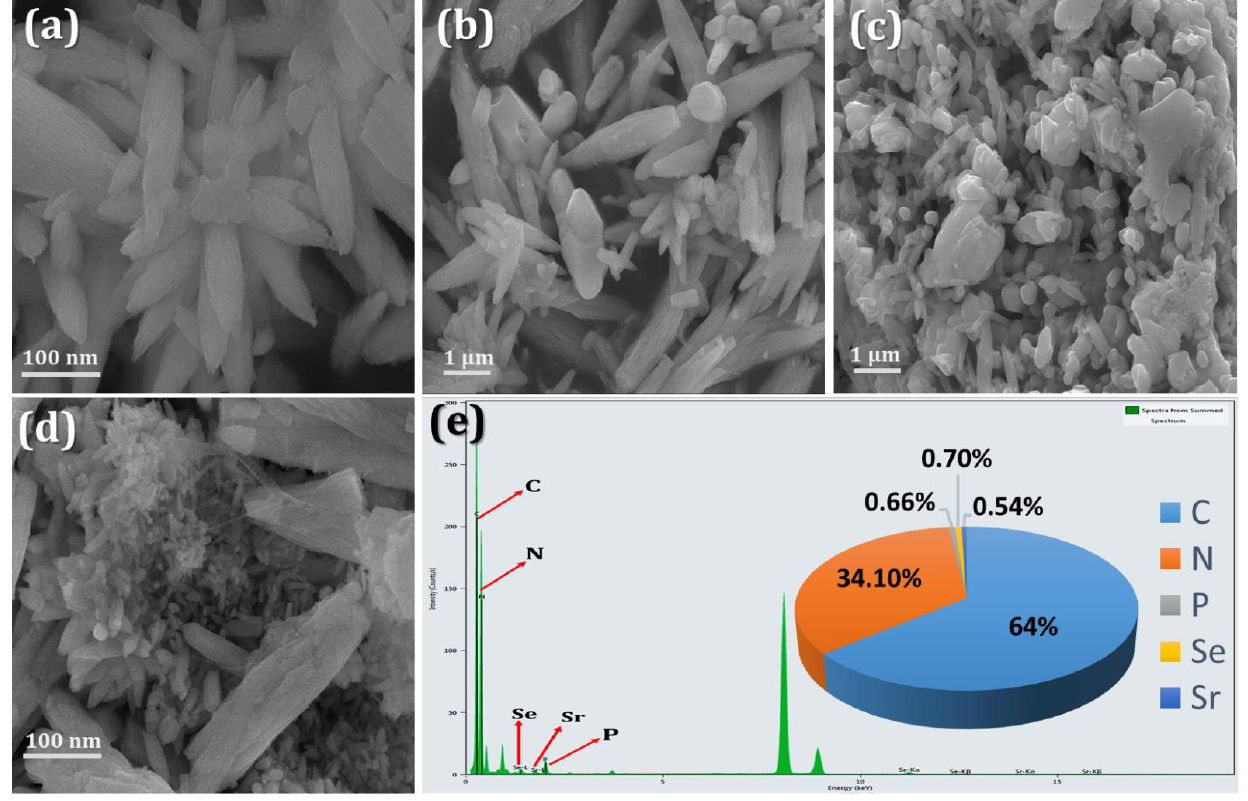
Figure 2. FE-SEM images of ( a , b ) Sr@Se, ( c ) PGCN, and ( d ) Sr@Se/PGCN nanocomposite and ( e ) EDX spectra of nanocomposite with corresponding weight percentages (inset).